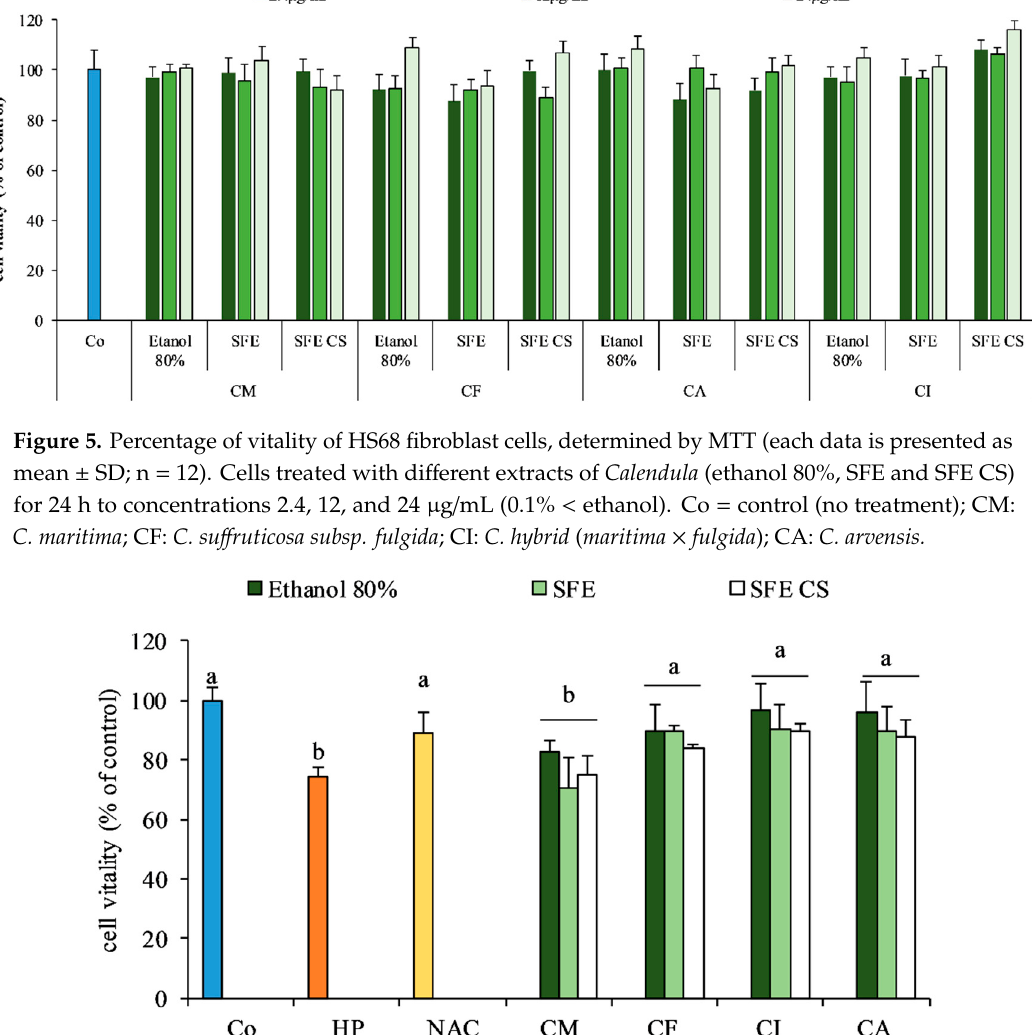
Figure 5. Percentage of vitality of HS68 fibroblast cells, determined by MTT (each data is presented as mean ± SD; n = 12). Cells treated with different extracts of Calendula (ethanol 80%, SFE and SFE CS) for 24 h to concentrations 2.4, 12, and 24 µg/mL (0.1% < ethanol). Co = control (no treatment); CM: C. maritima ; CF: C. suffruticosa subsp. fulgida ; CI: C. hybrid ( maritima × fulgida ); CA: C. arvensis.